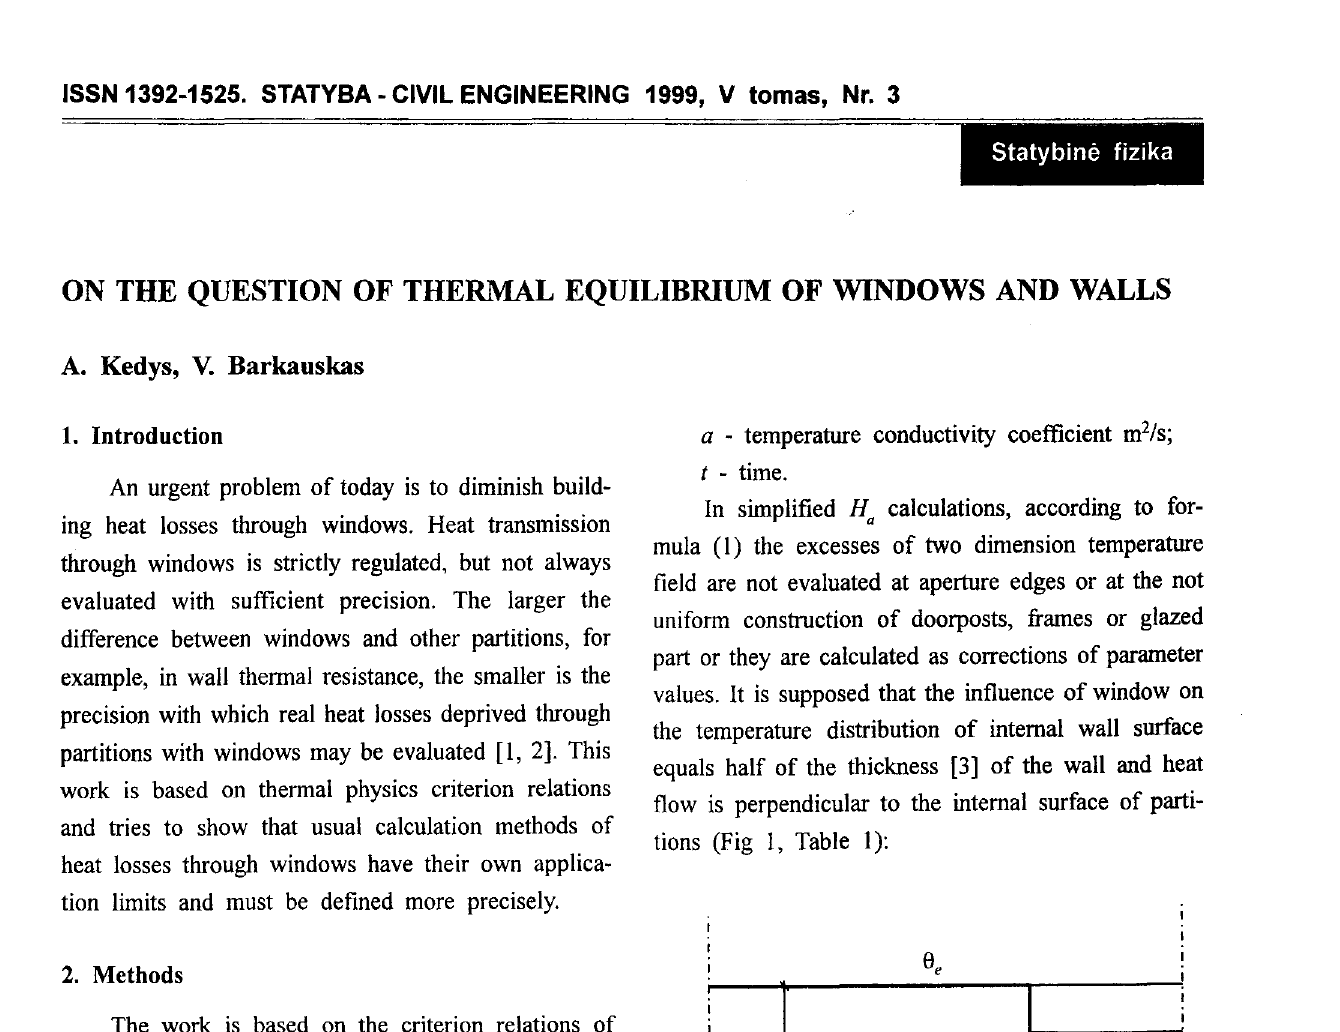
Fig I. Characteristic points of partition (walls and win dows) thermal state in calculating according to formula 1. Table 1. The values of thermal behaviour parameters